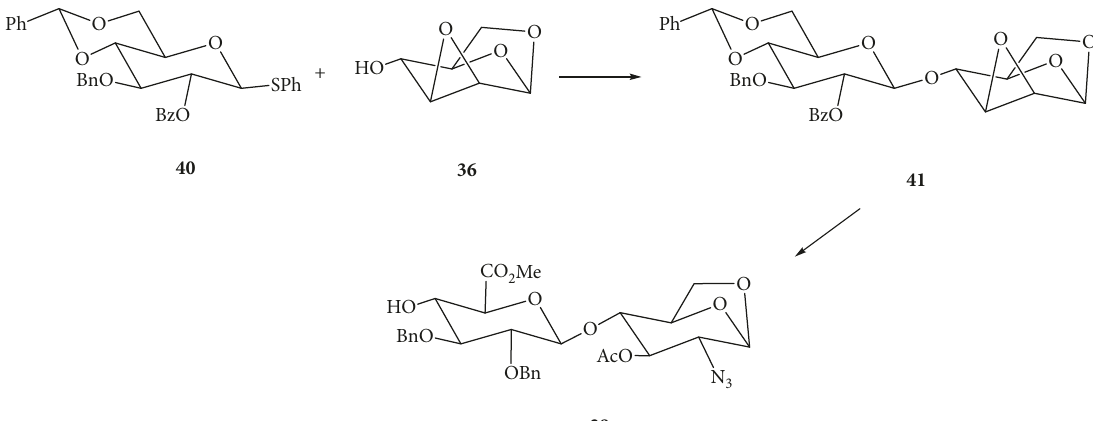
Scheme 13: Synthesis of DC disaccharide by Scino’s